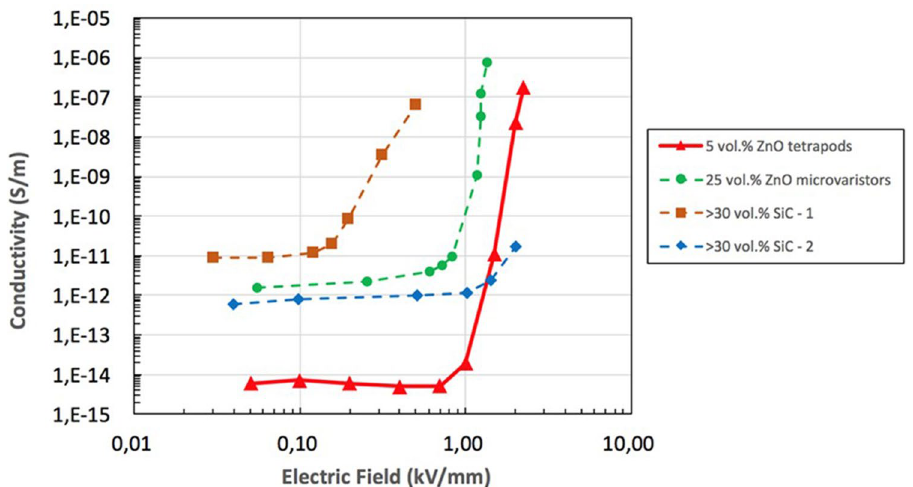
Figure 3. Comparison between different field grading materials at ambient temperature with typical loadings used to achieve RFG: 5 vol% ZnO tetrapods in silicone rubber compared to ZnO micro varistors and to two different SiC rubber composites, used for cable termination applications (SiC-1) and for cable joints (SiC-2) respectively 19